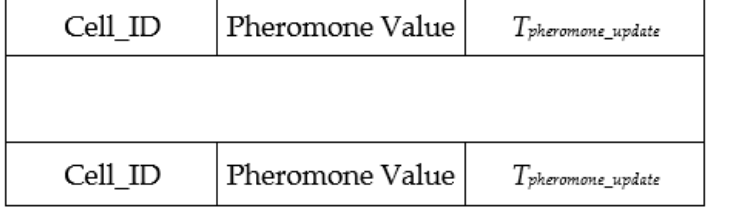
Figure 3. Data table format for storing the list of one ‐ hop neighbors. Figure 4 presents the two ‐ hop neighbor table format. A UAV updates the two ‐ hop neighbor entry whenever it receives a new list of neighbors from the one ‐ hop neighbors. Moreover, a two ‐ hop neighbor entry expires whenever the TTL of the corresponding one ‐ hop neighbor expires. Figure 4. Data table format for storing the list of two ‐ hop neighbors. Finally, Figure 5 illustrates the table format for storing the location information of the UAVs.